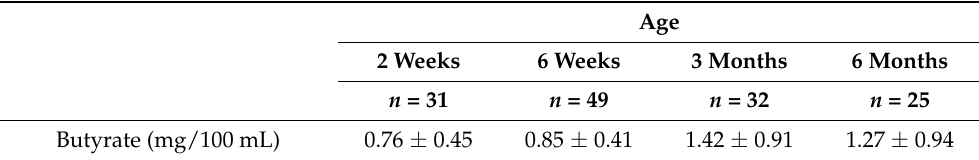
Table 2. HM butyrate concentrations over